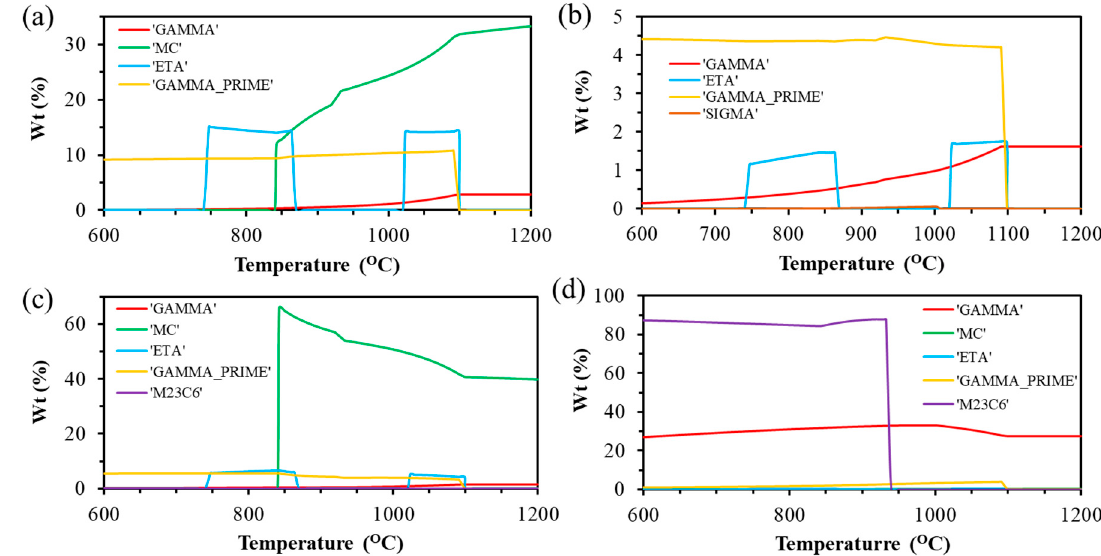
Figure 5. Changes in precipitation phases in IN-939 with temperature; ( a ) Ti, ( b ) Al, ( c ) Ta and ( d ) Cr.